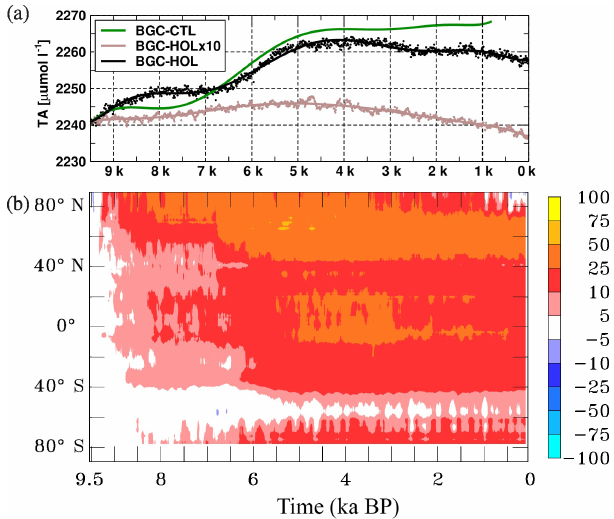
Figure 8. As Fig. 2 but (a) for the average NO 3 concentration aver- aged over the uppermost 100m in µmol CL − 1 and (b) Hovmöller diagram of the changes in zonal and annual mean NO 3 concentra- tion in the upper 100m in µmol CL − 1 . For NO 3 units divide by 7.6.